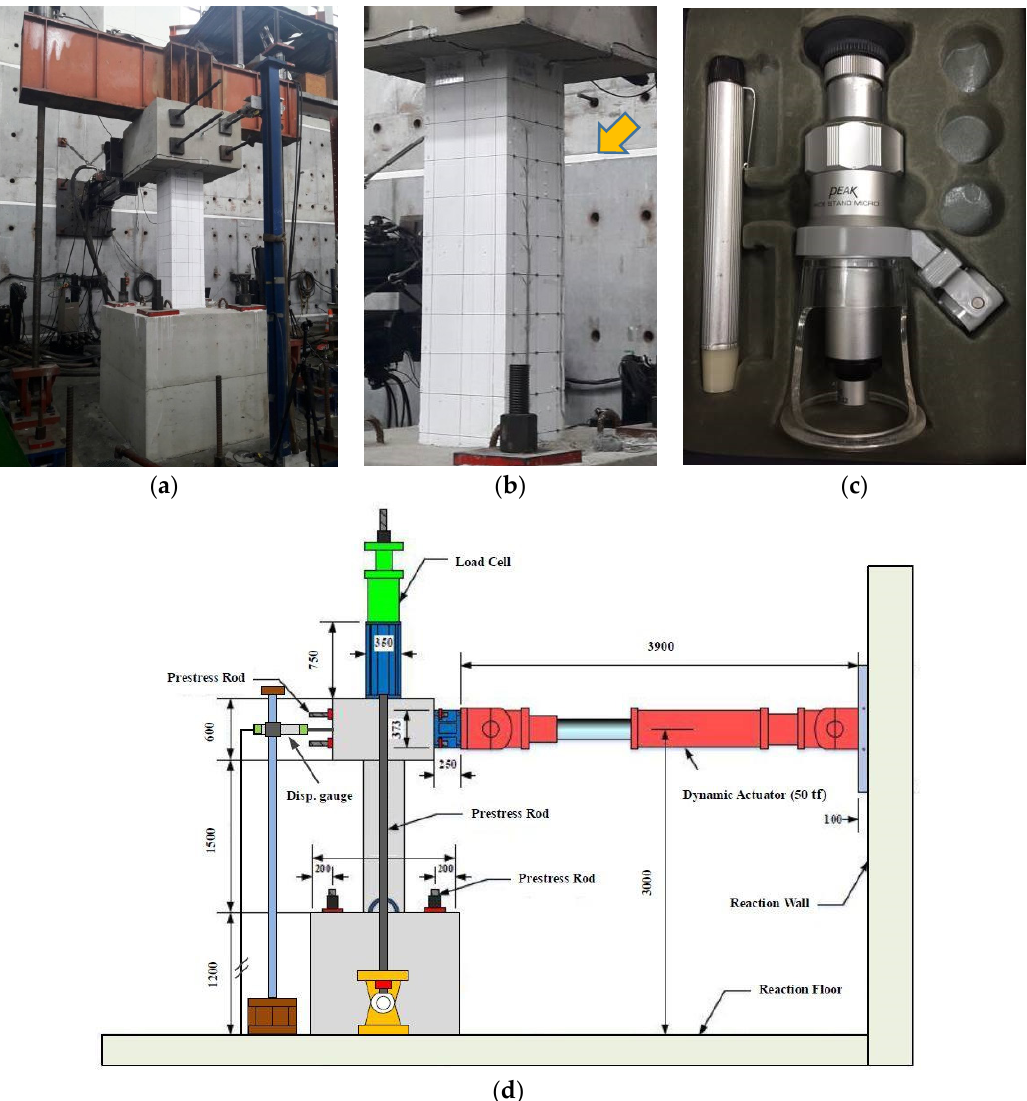
Figure 3. Experimental set up and positions of markers. ( a ) Specimen setup; ( b ) Markers of the optical measuring system; ( c ) Microscope; ( d ) Detail of testing setup. Appl. Sci. 2020 , 10 , x FOR PEER REVIEW Table 2. Properties of the piezoceramic transducers (Model: ped20t10s-md3 (produced by ELECERAM TECHNOLOGY CO., LTD)).